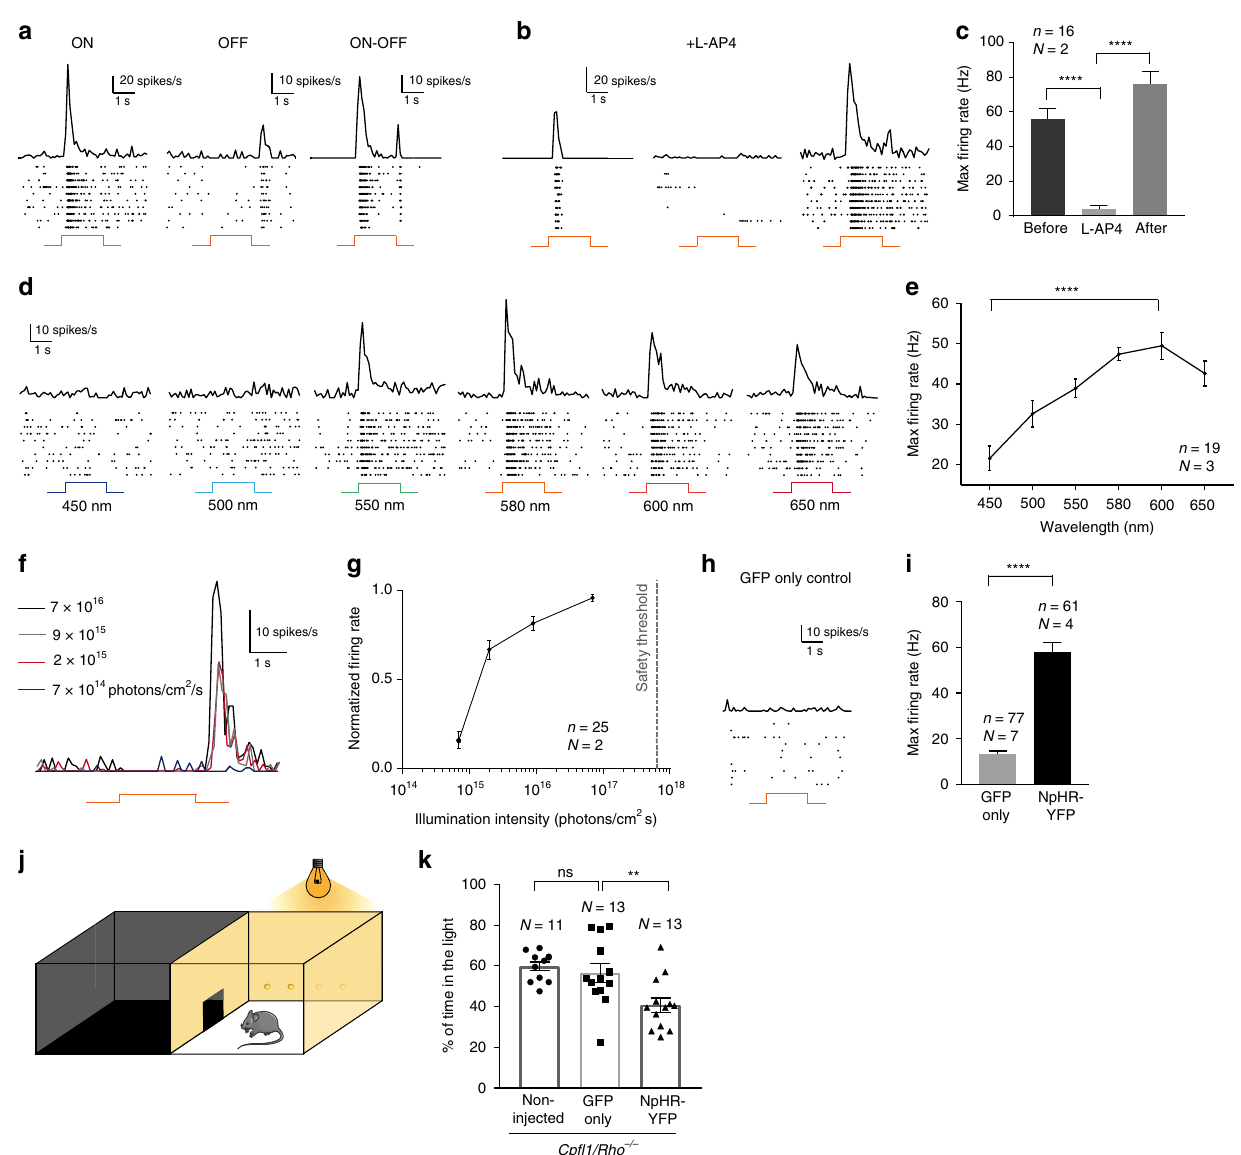
Fig. 3 NpHR-triggered responses are transmitted to RGCs and induce light avoidance behaviour. a – i Averaged spike responses obtained from multi-electrode array (MEA) recordings shown as PSTH and raster plots recorded in transplanted Cp fl 1/Rho − / − mice (stimulation: 580nm, 7×10 16 photons cm − 2 s − 1 ). a Representative traces from three RGCs responding either with an ON-, OFF-, or ON/OFF-response pattern. b Representative traces from a cell before, during ON bipolar cell blockade, and after wash-out, and c quanti fi cation of maximum fi ring rates for these conditions. d Representative responses to wavelengths ranging from 450nm to 650nm. e Quanti fi cation of RGC action spectrum (shown for OFF responses). The cells reach their peak fi ring rate at 580nm (ON responses, data not shown) and 600nm (OFF responses). f PSTHs of a single RGC responding to stimuli of increasing intensities (from 7×10 14 to 7×10 16 photons cm − 2 s − 1 ). g Intensity curve. The dashed line indicates the maximum light intensity allowed in the human eye at 590nm 20,21 . h Unresponsive cell from a control retina transplanted with GFP only-expressing photoreceptors. i Maximum fi ring rate in mice treated with GFP only photoreceptors versus mice treated with NpHR-photoreceptors (shown for ON responses). j Schematic representation of the dark/light box test. k Percentage of time spent in the light compartment for: non-treated Cp fl 1/Rho − / − mice, Cp fl 1/Rho − / − mice treated with GFP only photoreceptors, and Cp fl 1/Rho − / − mice treated with NpHR- photoreceptors (illumination: 590nm, 2.11×10 15 photons cm − 2 s − 1 ). In all panels: The timing and duration of stimulation is depicted with underlying orange lines (for 580nm stimuli; a , b , f , h ) or with a black line with associated wavelengths noted below ( d ). N = number of retinas, n = number of cells. Values are mean±SEM. Corresponding data points are overlaid in ( k ). Error bars are SEM. Statistical signi fi cance assessed using Mann – Whitney Student ’ s test (** p <0.01; **** p <0.0001; ns — not signi fi cant). Source data are provided as a Source Data fi le (for c , e , g , i , k